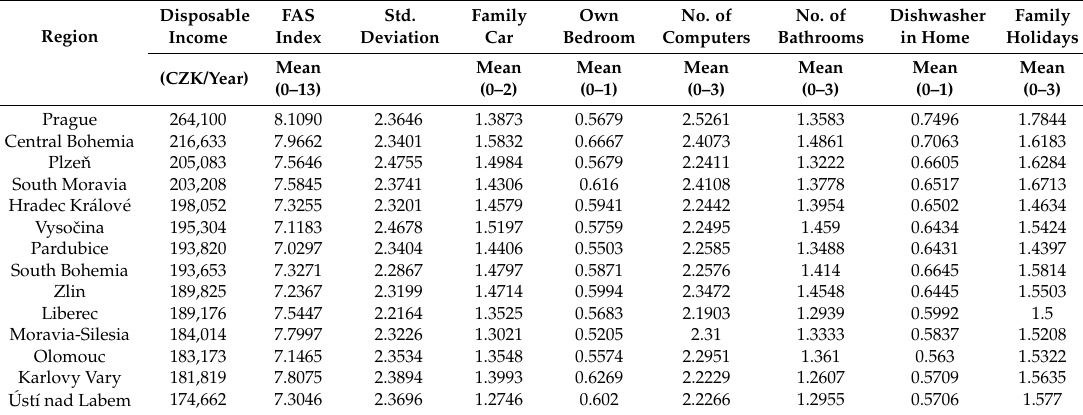
Table 2. Regional details of disposable income, Family Affluence Scale (FAS) index, and FAS component items.